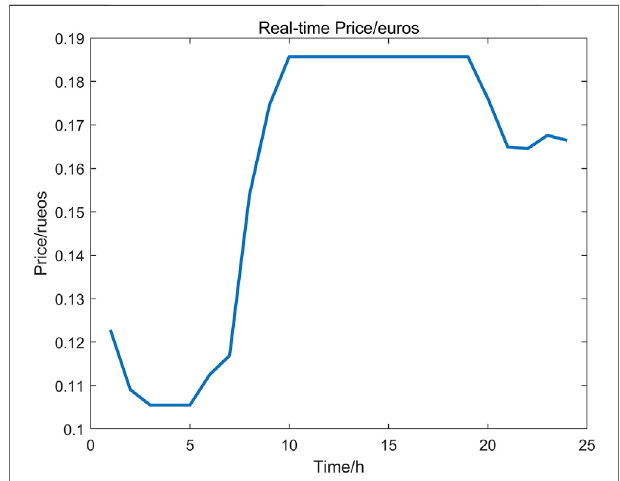
FIGURE 10 | Real-time electricity price in 24 h